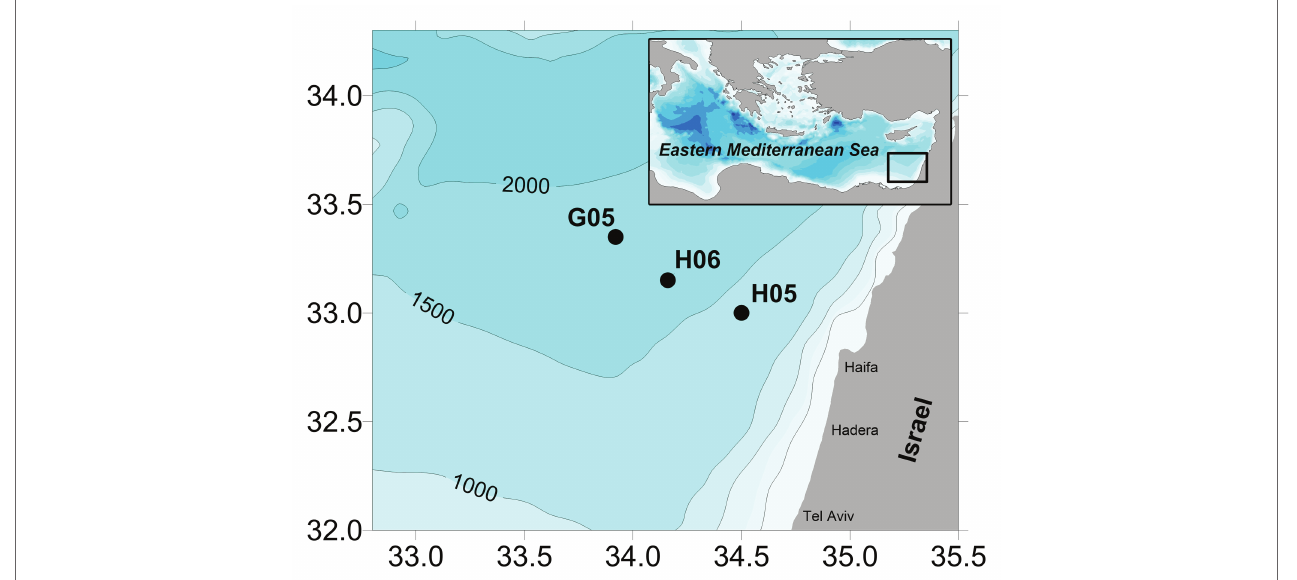
FIGURE 1 | A map showing the study site in the southeastern Mediterranean (SEMS) Sea and the long-term monitoring